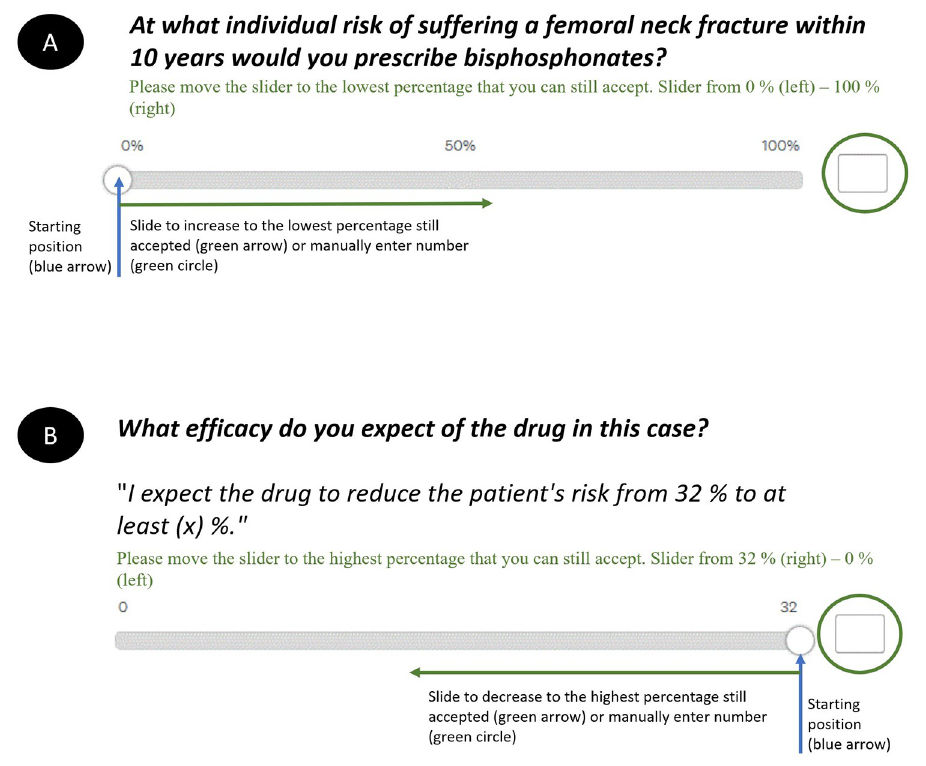
Fig 1. Exemplary depiction of the physicians’ survey to display treatment threshold (A) and demanded minimum ARR (B). The different starting positions (blue arrows) and the different sliding directions (green arrows) in order to actively increase/decrease risk value. Manual entry was able by entering numbers in the text field (green